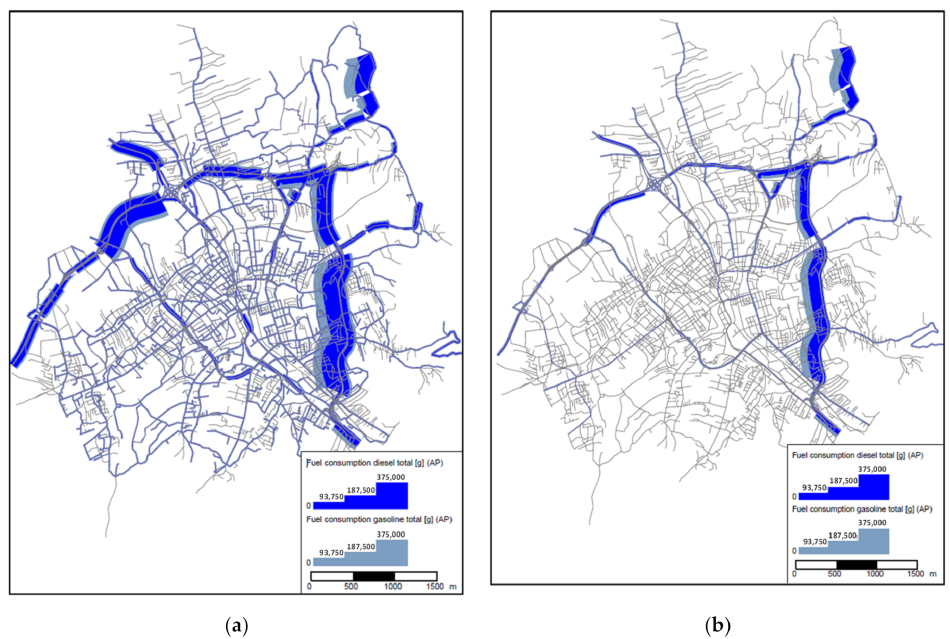
Figure 11. The assessment of fuel consumption diesel total [g] and fuel consumption gasoline total [g] (measures from Group 2) for scenario W0 and optimal scenario (W4)—analysis for the whole city: ( a ) measures for scenario W0; ( b ) measures for scenario